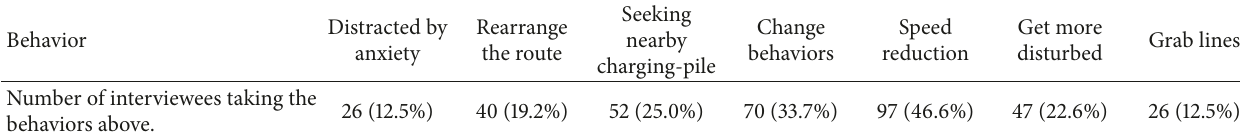
Table 4: Statistics of driver’s behaviors taken related to range anxiety.